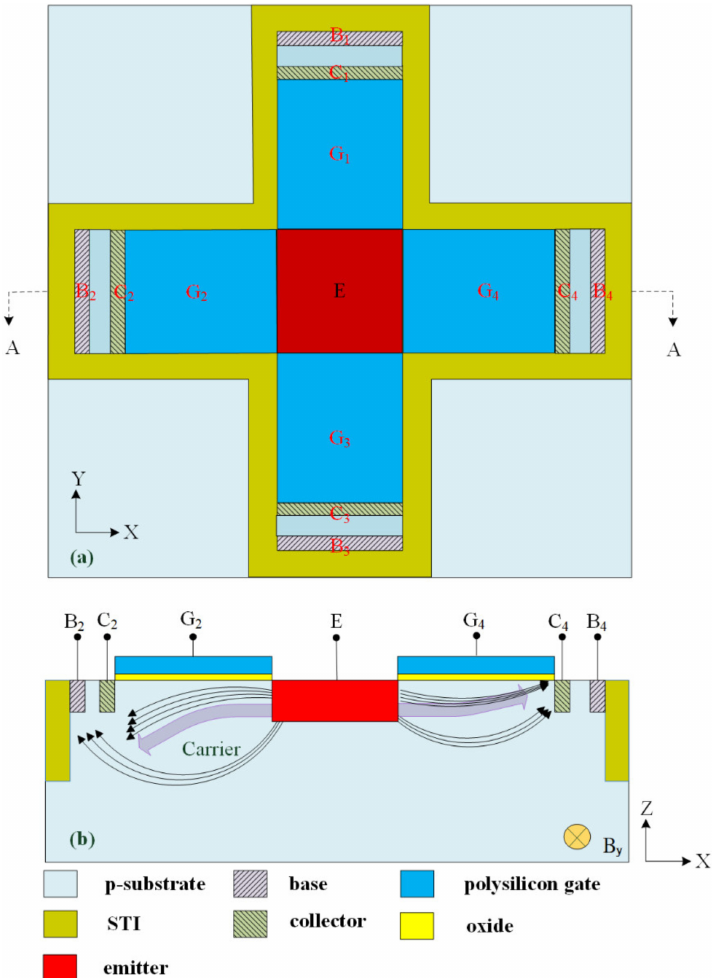
Figure 1. ( a ) Structure of the x / y magnetic field e ff ect transistor (MAGFET); ( b ) Cross-sectional view of the x / y-MAGFET along line